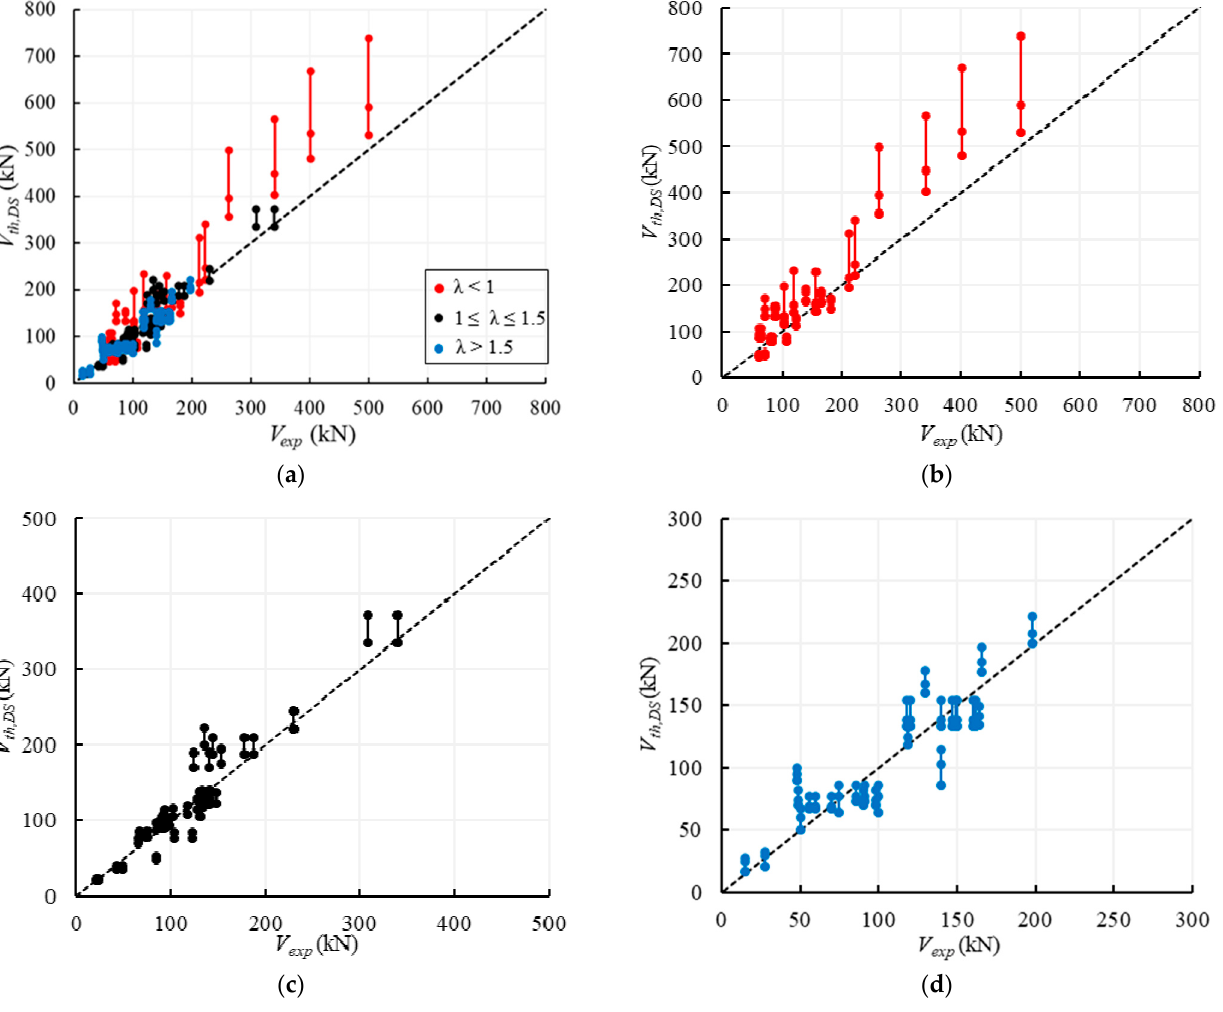
Figure 13. Experimental vs. theoretical results for regular masonry walls: ( a ) all data; ( b ) λ < 1; ( c ) 1 ≤ λ ≤ 1.5; ( d ) λ >1.5.